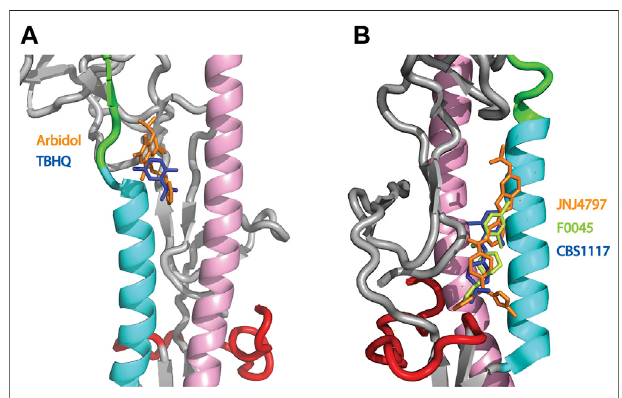
FIGURE4| Structuresofsmallmoleculeinhibitorsthoughttodisruptthe pH trigger of HA. (A) Overlay of Group 2 inhibitors TBHQ (blue) and Arbidol (orange). PDB fi les correspond to 3EYM and 5T6N for the TBHQ and Arbidol complexes, respectively. (B) Overlay of Group 1 inhibitors JNJ4797 (orange), F0045 (lime) and CBS1117 (blue). PDB fi les correspond to 6FCG, 6WCR and 6VMZ for the JNJ4797, F0045 and CBS1117 complexes, respectively. In both panels, the coloring scheme of the backbone is that of Panel